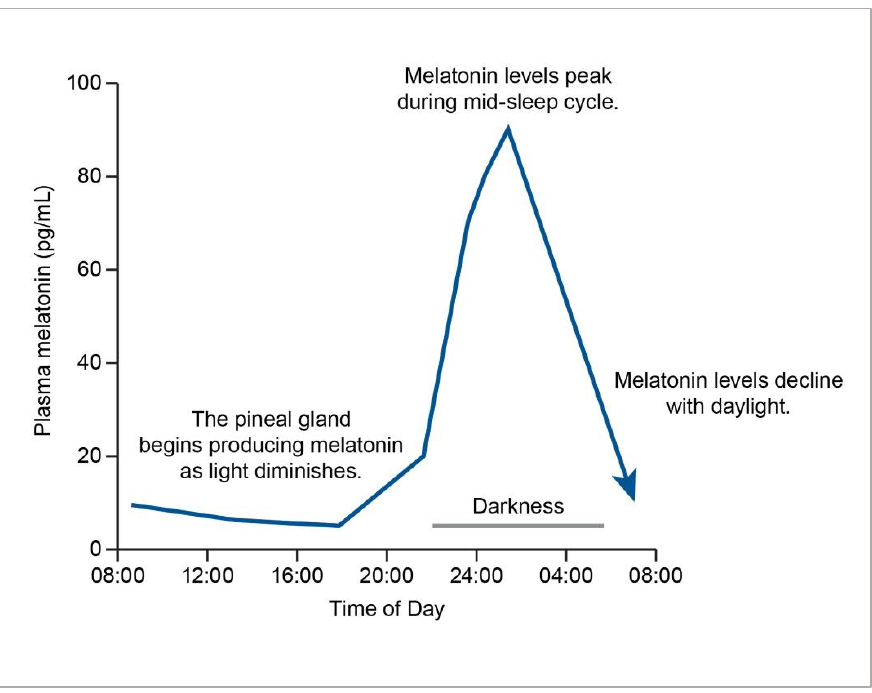
Figure 9. Melatonin production throughout the day. Modified from [10]. Figure 2. Melatonin production throughout the day. Modified from